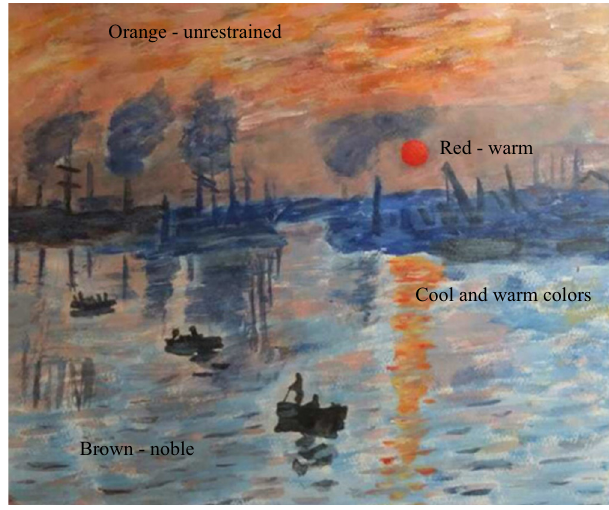
Figure 7: Color emotional characteristics of the impression of